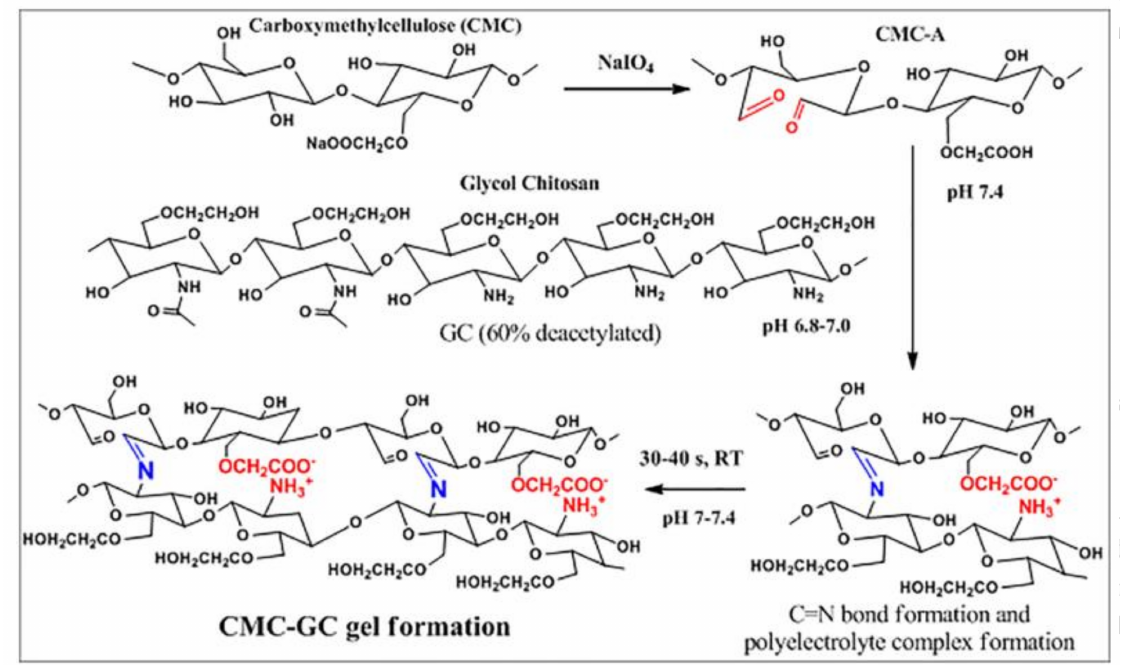
Figure 3. Probable mechanism of gel formation using Schiff’s base reaction method.